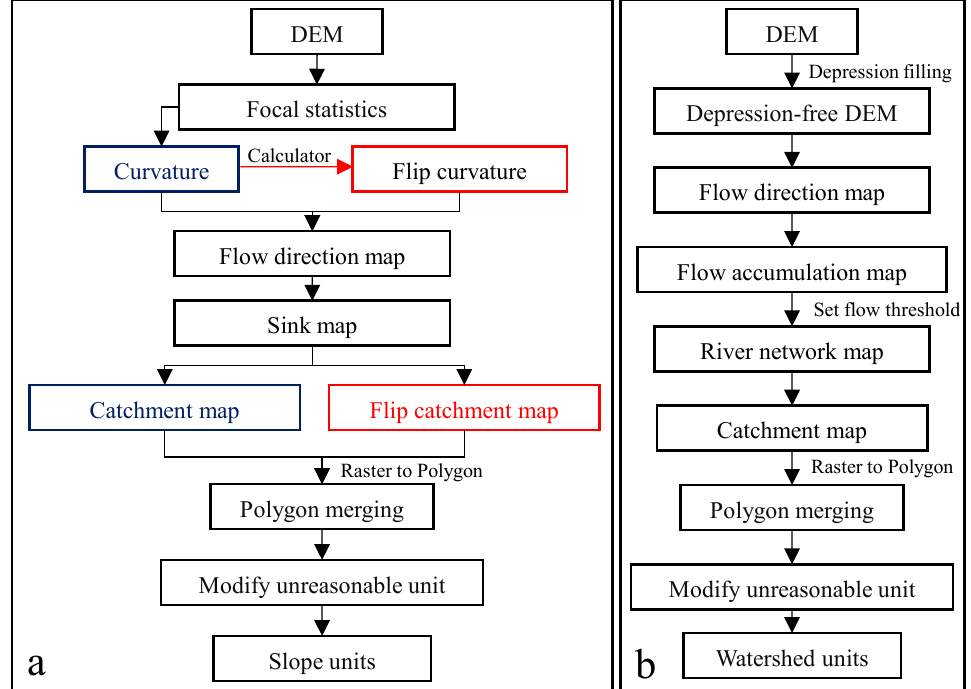
Figure 2. Division process of the mapping unit: ( a ) slope unit; and ( b ) watershed unit.